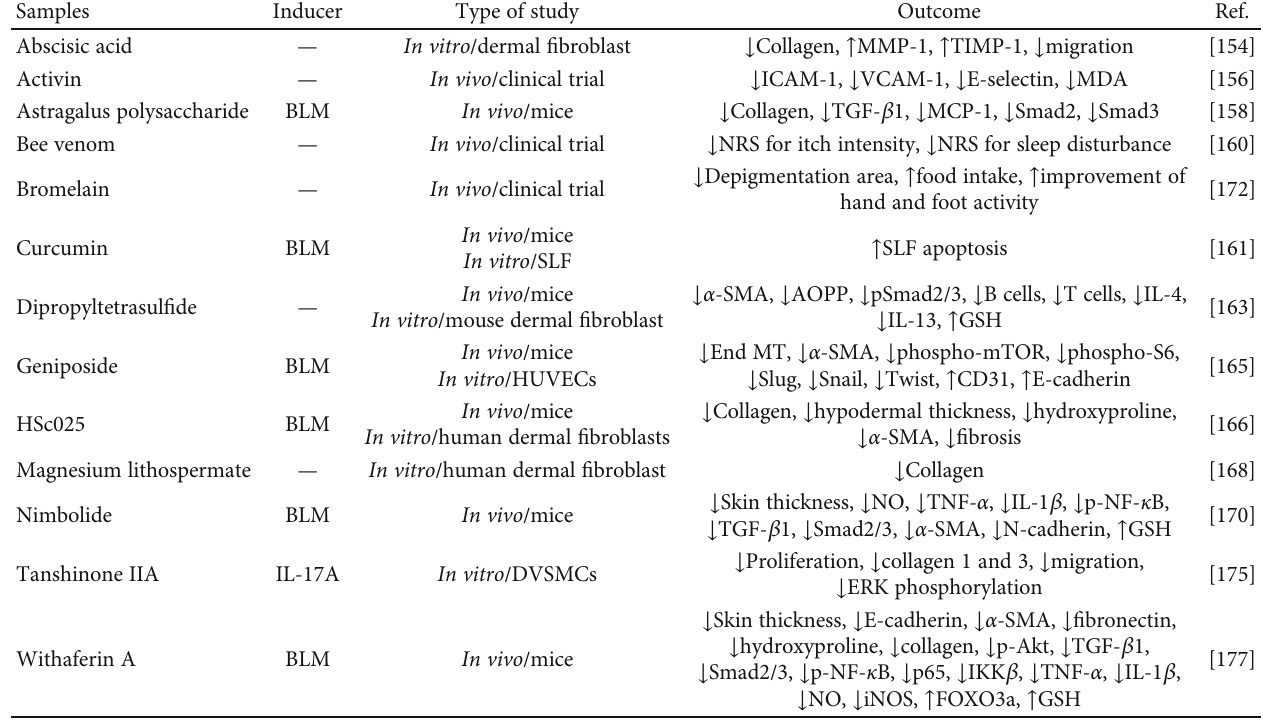
Table 2: In vitro , in vivo , and clinical interventions of natural therapeutics for scleroderma treatment. Samples Inducer